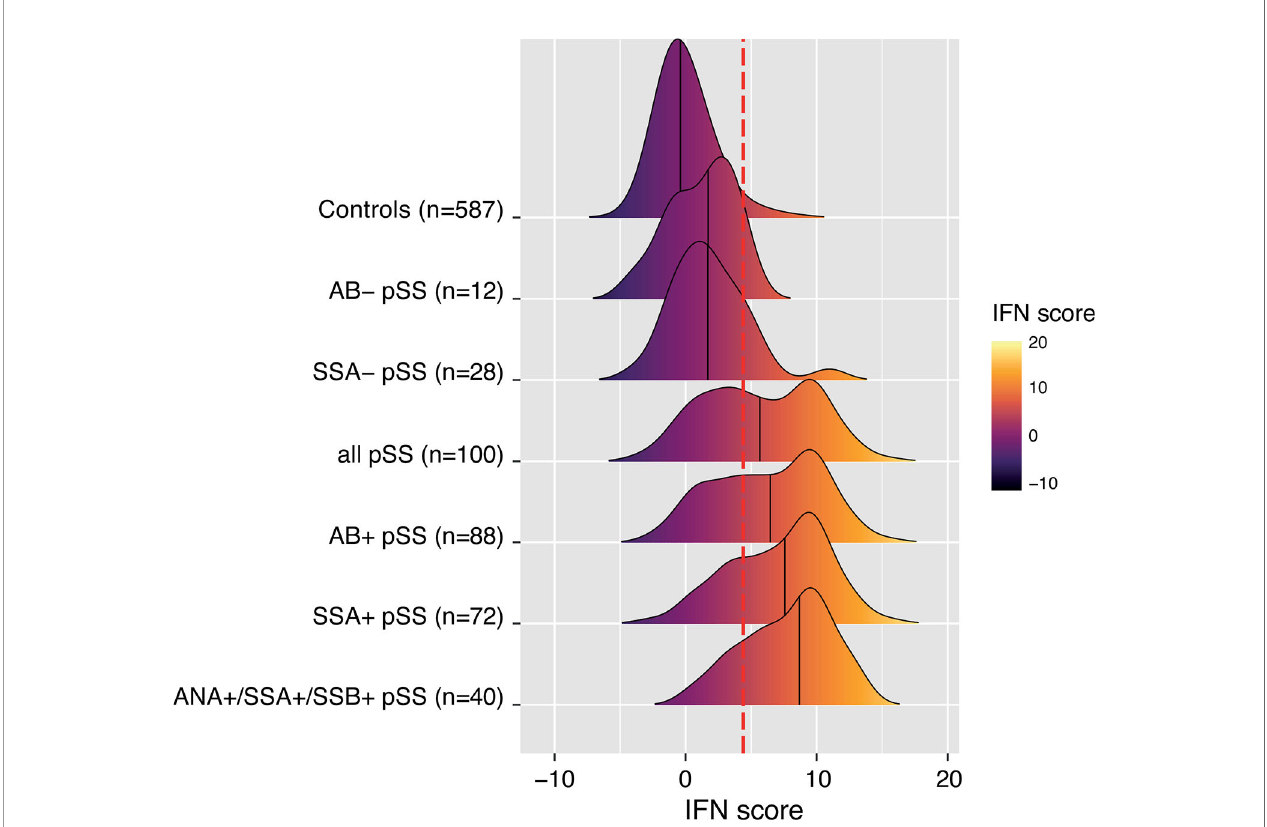
FIGURE 2 | Ridges plot representing the distribution DNAm-based IFN scores in controls and subgroups of patients with pSS from the discovery cohort de fi ned by autoantibody status. An individual patient can be part of one or several pSS subgroups. Ridges are sorted by increasing group median indicated by the black vertical line within each ridge. Ridges gradient indicates low (dark purple) to high (light yellow) DNAm IFN score levels. The dotted red vertical line indicates the threshold for high IFN score (DNAm IFN score > 4.4 corresponding to > mean IFN score ctrl +2s.d. ctrl